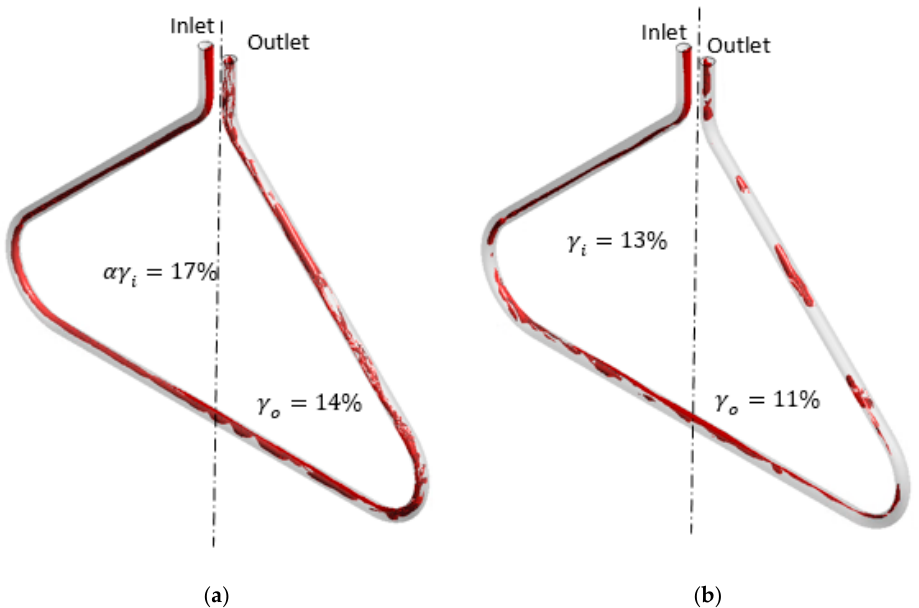
Figure 11. The gas distribution in flowmeter tube at different flow conditions obtained by numerical simulation at stratified and transitional flow regimes for CMF200. ( a ) 60.8 kg/min mixture flow rate, 9% GVF at the inlet, 13% gas asymmetry ( γ d ) , CMF200. ( b ) 149.0 kg/min mixture flow rate, 9% GVF at the inlet, 3% gas asymmetry ( γ d ) , CMF200. ( c ) 60.8 kg/min mixture flow rate, 16% GVF at the inlet, 38% gas asymmetry ( γ d ) , CMF200. ( d ) 100.0 kg/min mixture flow rate, 16% GVF at the inlet, 18% gas asymmetry ( γ d ) , CMF200. ( e ) 60.8 kg/min mixture flow rate, 13% GVF at the inlet, 33% gas asymmetry ( γ d ) , CMF200.